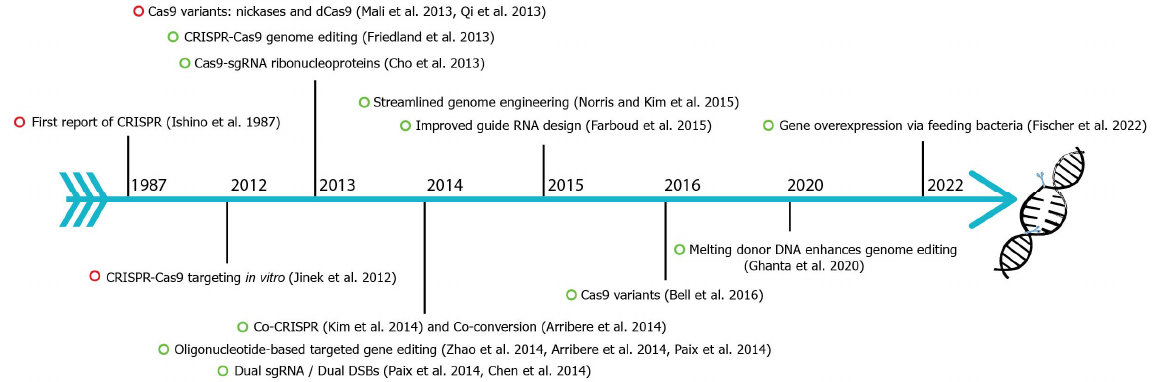
Figure 1. Overview of the CRISPR-Cas9 genome editing approach in C. elegans . The gonads of adult hermaphrodites are injected with the CRISPR-Cas9-containing DNA mixture. Injected Cas9 (grey color) forms a sequence-specific endonuclease when complexed with crRNA and trRNA (together called a guide RNA, or single guide RNA). The Cas9-guide RNA complex recognizes a target DNA sequence containing a PAM sequence (NGG) and induces a double-strand break (DSB), which will be repaired by non-homologous end joining (NHEJ) or homologous recombination (HR/HDR). Transgenic worms will be identified via marker-free (PCR) or marker-dependent strategies [1].